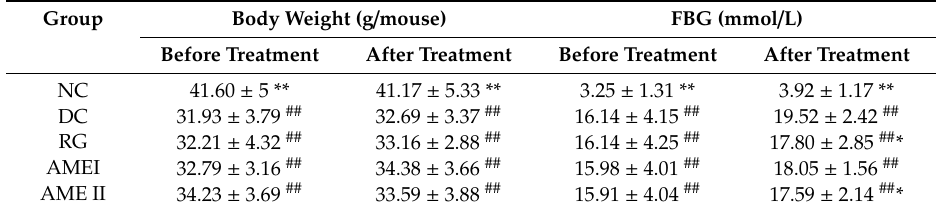
Table 1. E ff ects of amentoflavone (AME) on body weight and Fasting Blood Glucose (FBG) levels in _ diabetic mice ( x ± SD, n = 10). Group Body Weight (g / mouse) FBG (mmol / L) After Treatment Before Treatment